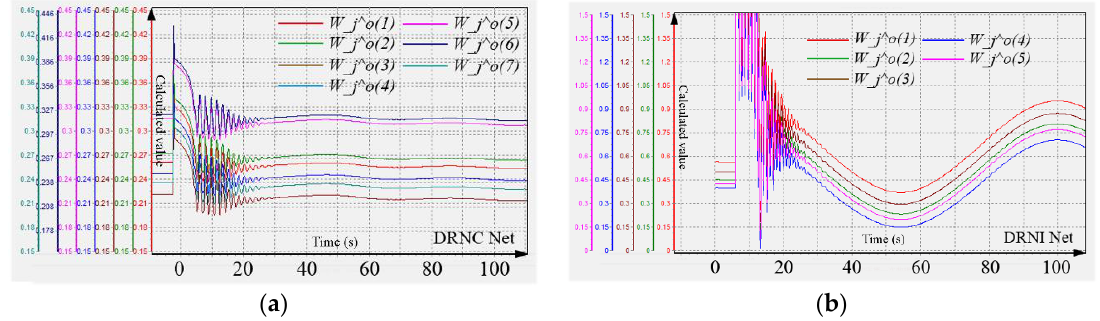
Figure 9. Convergence of the DRNN weights for the reference mode: ( a ) DRNC, ( b ) DRNI.